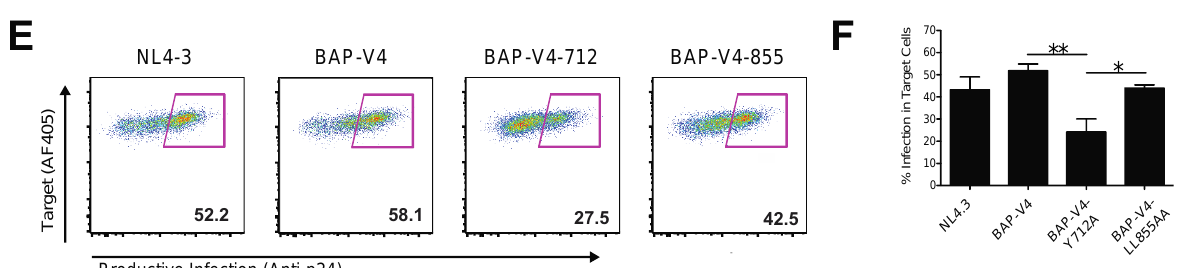
Figure 4. Endosomal recycling pools of Env support the coordinated cell–cell transfer of Gag and Env to promote productive infection across VS. J-BirA cells were infected with a series of HIV point mutant viruses (Y712A; LL855AA) that inhibit Env endocytosis/recycling from the surface of infected cells and which expressed the Bap tag in the V4 loop. ( A ) HIV- infected cells were labeled with anti-biotin Ab at 37 ◦ C followed by intracellular Gag quantification using an anti-p24 Ab. FACS plots show the level of Env surface expression on the surface of pNL4-3-, BAP-V4-, BAP-V4-Y712A- and BAP-V4- LL855AA-infected J-BirA cells as quantified by anti-biotin antibody (top row) or the b12 anti-Env antibody (bottom row) and intracellular staining with a p24 anti-Gag Ab. ( B ) Graphs depict the MFI index (percentage of double positive cells multiplied by APC MFI) of the surface expression using anti-biotin (upper) or b12 antibody (bottom). The SEM of n = 3 experiments is shown. ( C ) HIV-infected and anti-biotin-labeled cells were used in 4 h cell–cell transfer experiments with violet dye-labeled primary CD4 T cells. The upper row of FACS plots depicts the level of Gag transfer (anti-p24, upper row) and Env transfer (anti-biotin-647, bottom row). ( D ) Upper graph represents the percentage of Gag p24 transferred into target CD4+ cells. Lower graph is the ratio between the Env transferred in the target cells and p24 in the donor cells. Graphs represent the SEM of n = 5 experiments. ( E ) Flow plots depict the level of p24 intracellular staining in primary target CD4 T cells 48 h after co-culture with HIV-infected donor cells. AZT was added after 6 h of cell–cell contact to limit the infection to a single round. ( F ) Graph shows the average level of productive infection in co-cultured target cells, as assessed by intracellular p24 staining. All donor cells were normalized to 40–50% p24-positive for cell–cell experiments. The SEM of Figure 5. n = 3 experiments is shown. Significance was assessed using a one-way ANOVA corrected for multiple comparisons using Bonferroni’s comparison test. * p ≤ 0.05, ** p ≤ 0.01, *** p ≤ 0.001, **** p ≤ 0.0001.